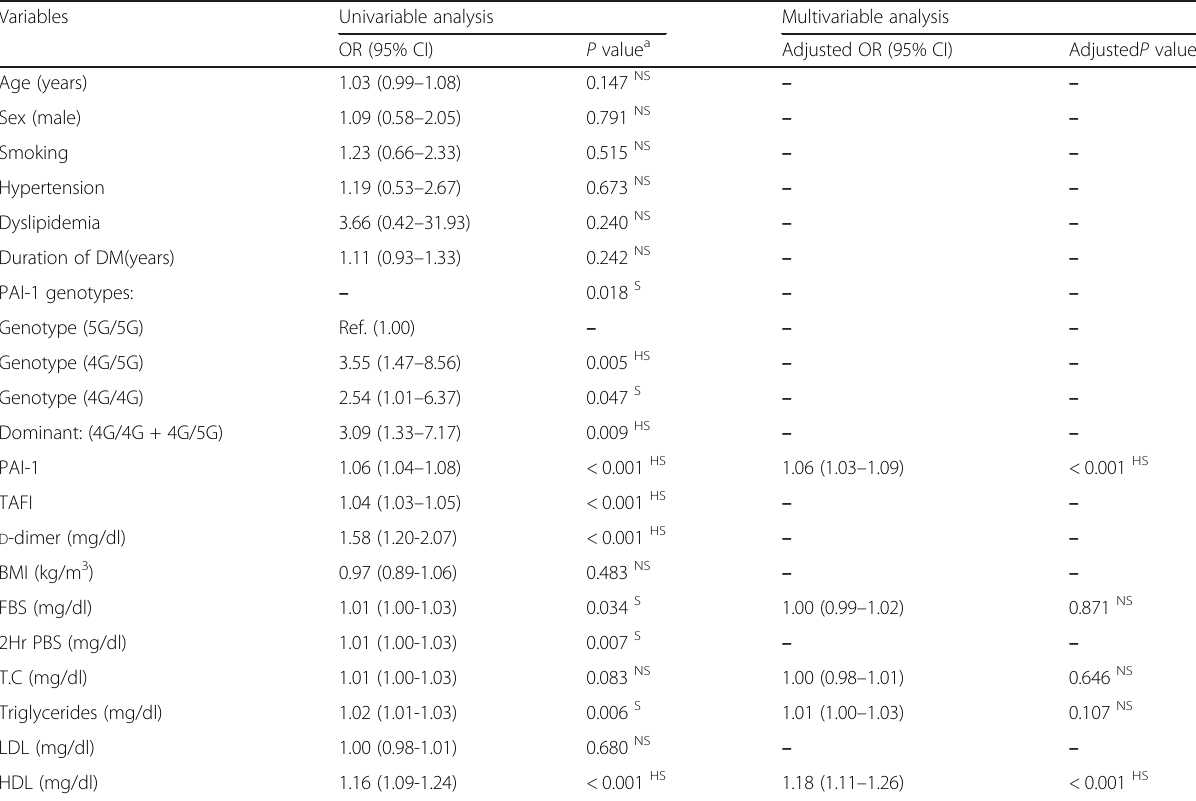
Table 5 Potential risk factors independently associated with vascular complications in diabetic patients